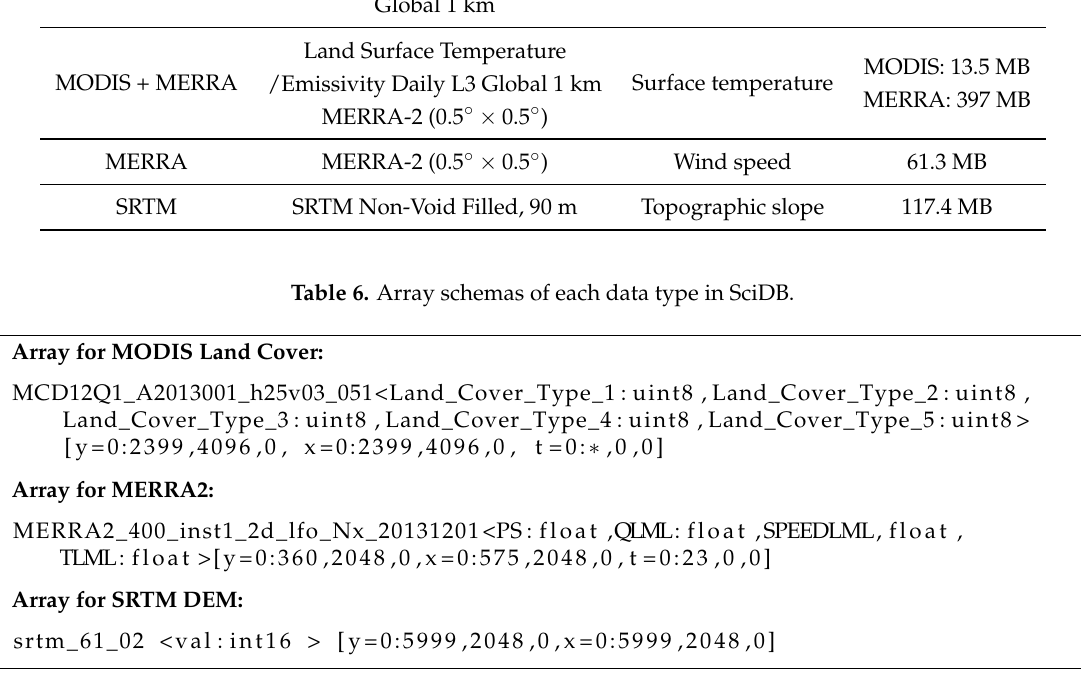
Table 5. Data items and their influence factors.